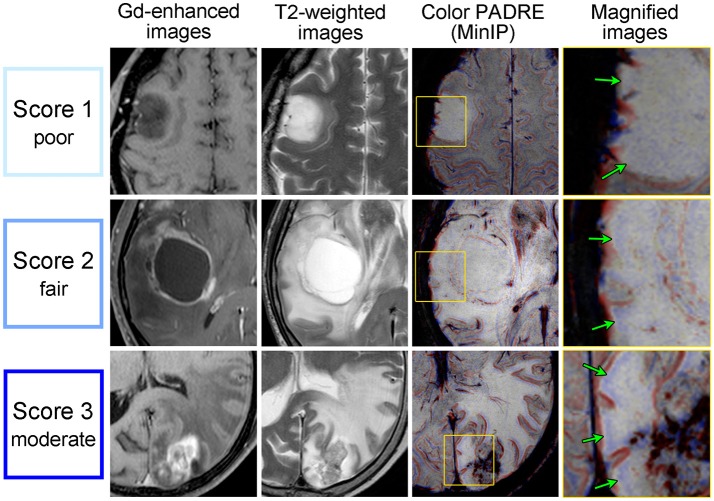
Gd-enhanced images (column 1), T2-weighted images (column 2) and Color PADRE (columns 3 and 4) of the representative cases with scores of 1–3 for SWM. The fourth column shows magnified images of the parts surrounded by yellow squares in the corresponding images in the third column. The first row shows score-1 images of a 43-year-old female with a DA; the second row shows score-2 images of a 67-year-old male with a GB; and the third row shows score-3 images of a 74-year-old female with a MT. No target area received a score of 4 regarding SWM. On Color PADRE, SWM is displayed as blue beneath the cortex. Green arrows in the fourth column indicate the SWM in non-Gd-enhancing T2-hyperintense regions.